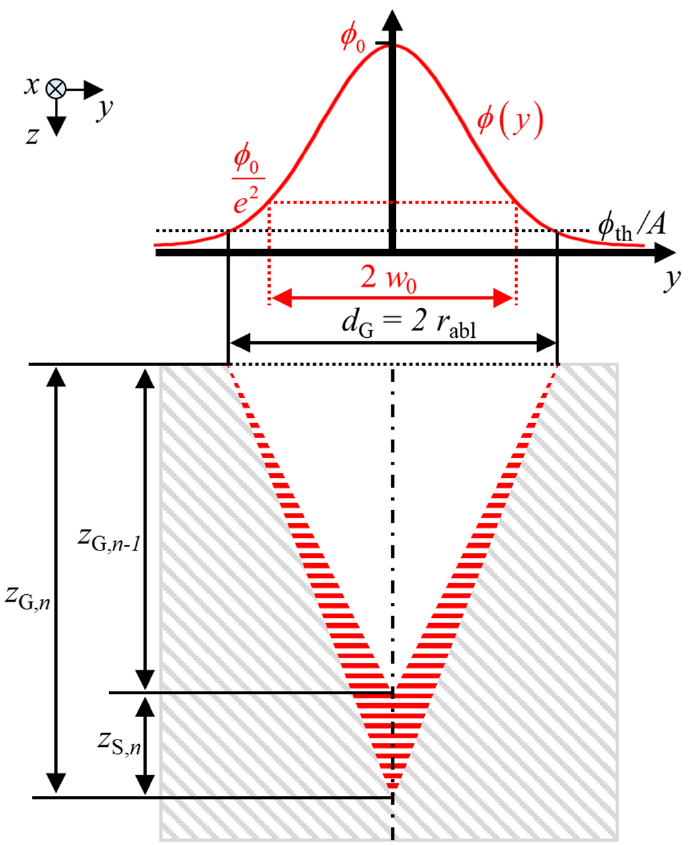
Figure 1. V-shaped groove produced by a pulsed laser beam which is scanned along the x -axis. The Gaussian distribution of the fluence of the individual laser pulses is shown by the red curve. The width of the groove is denoted by d G = 2 r abl , which corresponds to two times the ablation radius r abl . The incrementally increased depth of the groove is denoted by z G ,n , where n is the number of applied scans and z S, n = z G, n − z G, n − 1 is the incremental increase in the depth produced by the n th scan along the groove. The cross section of the volume ablated during the n th scan is highlighted by the red hatched cross section.